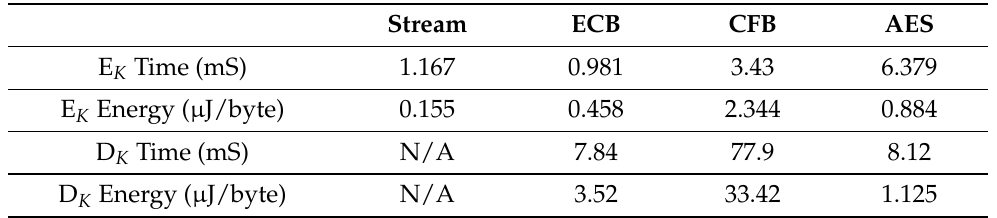
Table 3. Computation time and energy consumption for encryption and decryption operations on TI